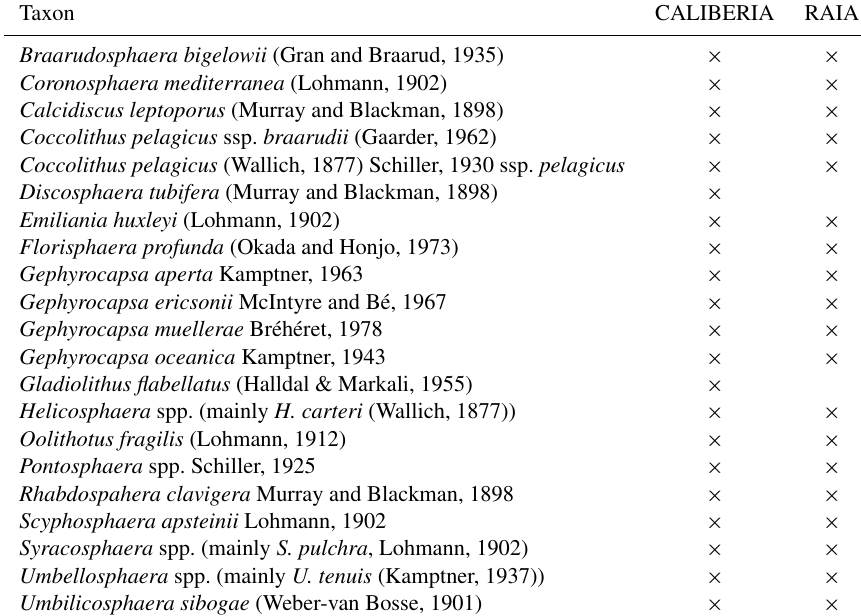
Table A1. Taxonomic list of the identified species. Their presence at each station is denoted by ×